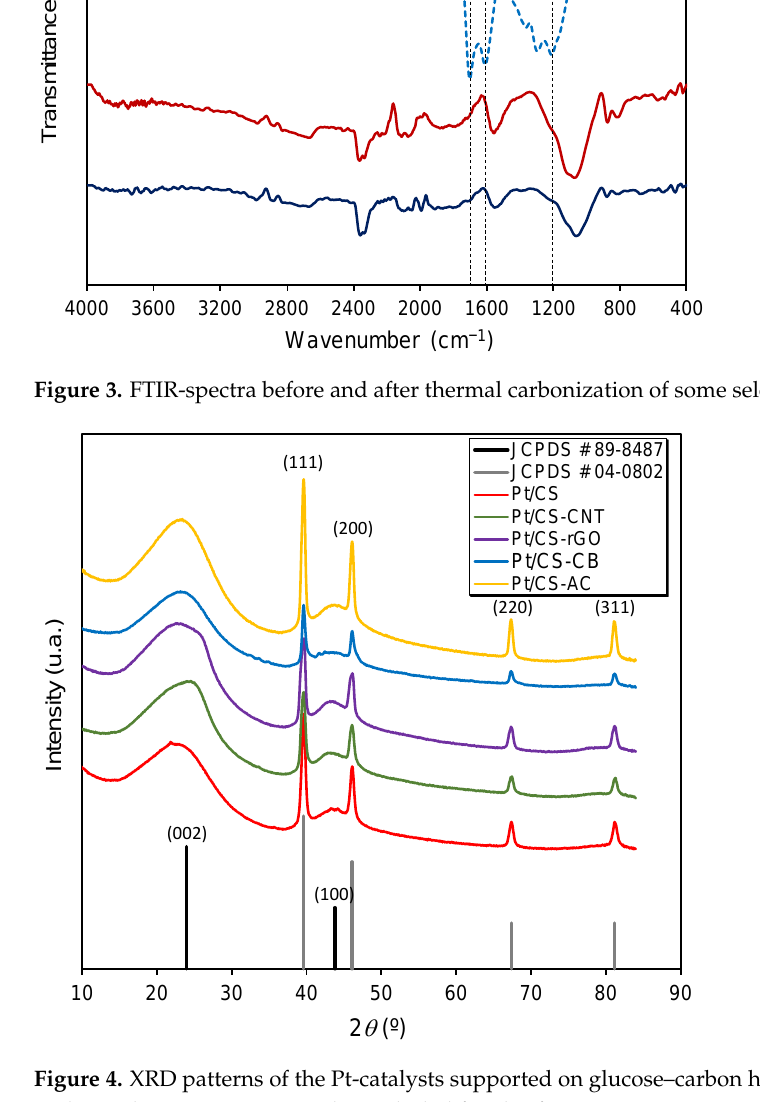
Figure 4. XRD patterns of the Pt-catalysts supported on glucose–carbon hybrids. JCPDS cards used in the peak’s assignment are also included for clarification.